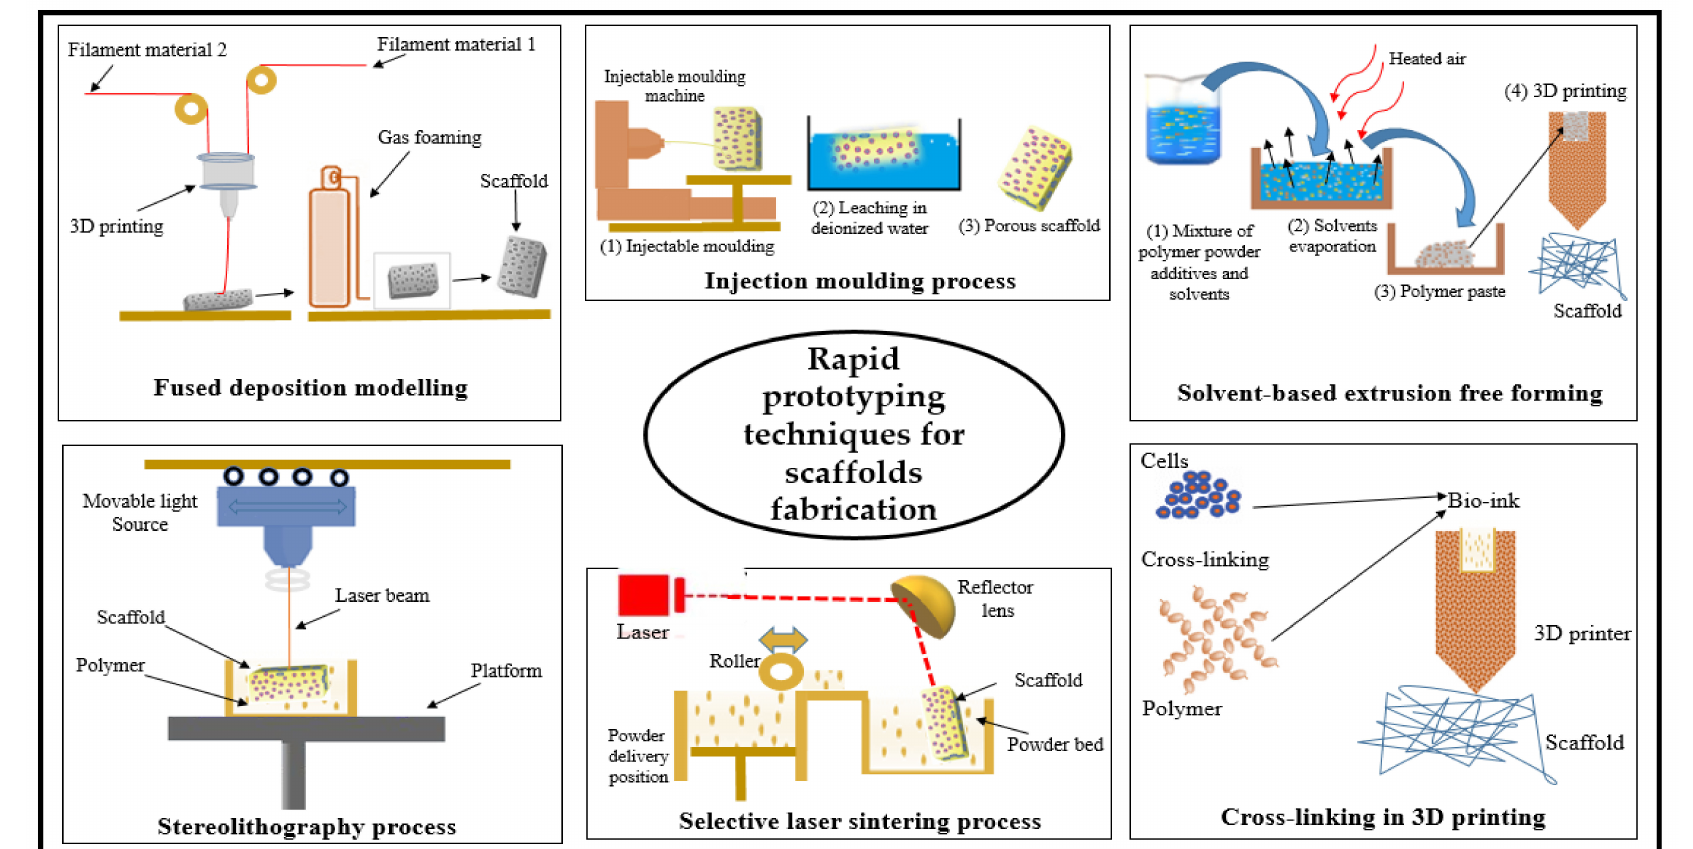
Figure 7. Schematic drawing of biopolymer forming rapid prototyping techniques for sca ff